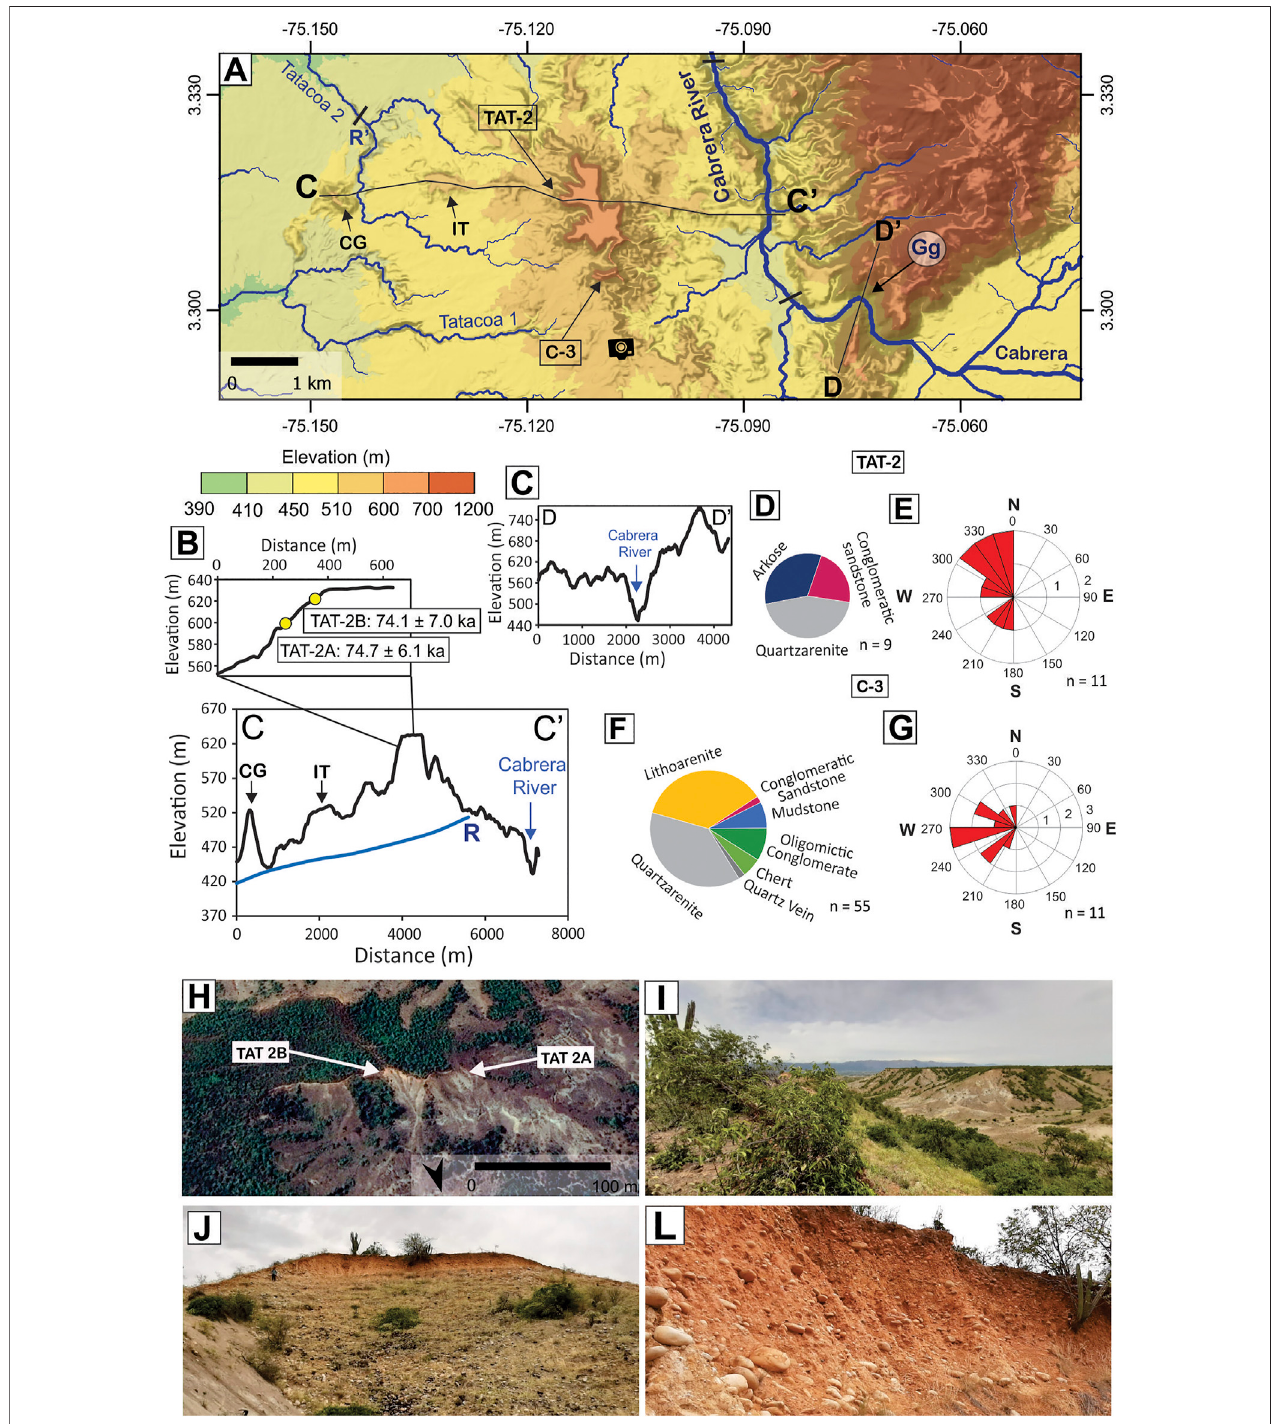
FIGURE5| DetailoftheTAT-2samplingsite. (A) Digitalelevationmodel(TanDEM-X,12 m);shadedareasarehillslopeshigherthan25 ° .Thetwosmalltracesinthe Cabrera River limit the segment used to extract river mean elevation for the calculation of incision rates; IT is an intermediate terrace level, CG is the Saldaña Formation rocks outcropping along theCerro GordoAnticline (see Figure 2 );and GgistheCabreraRiver Gorge; (B) topographicC-C ′ pro fi le and a reference riverpro fi le,in detail, sample elevation and OSL-ages, not that the TAT-2A is a minimum age (average 2D0 value). (C) topographic D-D ′ pro fi le; (D) modal gravel composition for the controlling point TAT-2; (E) paleocurrent direction for TAT 2 (raw data in Supplementary Table S5 ); (F) modal gravel composition for the controlling point C-3; (G) paleocurrent direction for C-3; (H) aerial image with samples location, source: Google Earth; (I) picture with a view from S of the terrace (location shown in map); (J) picture with a panoramic view of the controlling point C-3; and (L) picture with detail of the -~7 m thick deposit of the controlling point C-3.